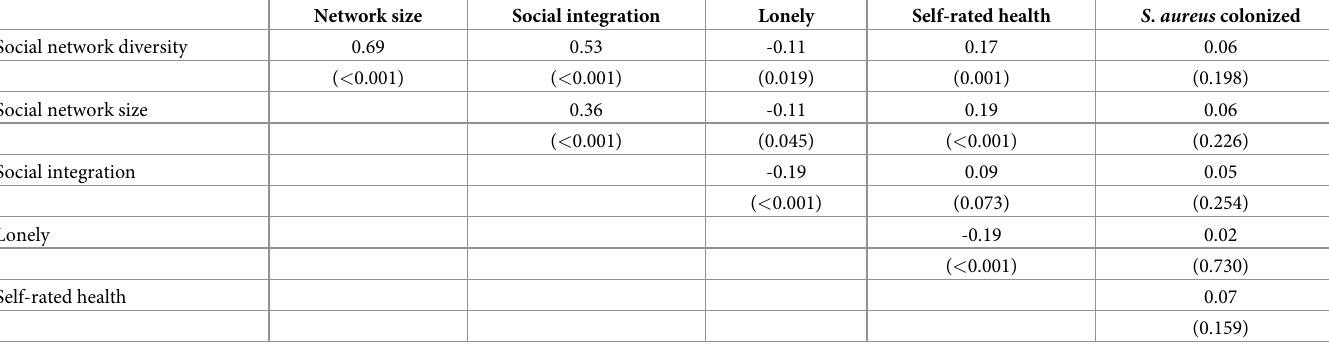
Table 2. Correlations among social relationship variables, self-rated health and colonization with S . aureus .